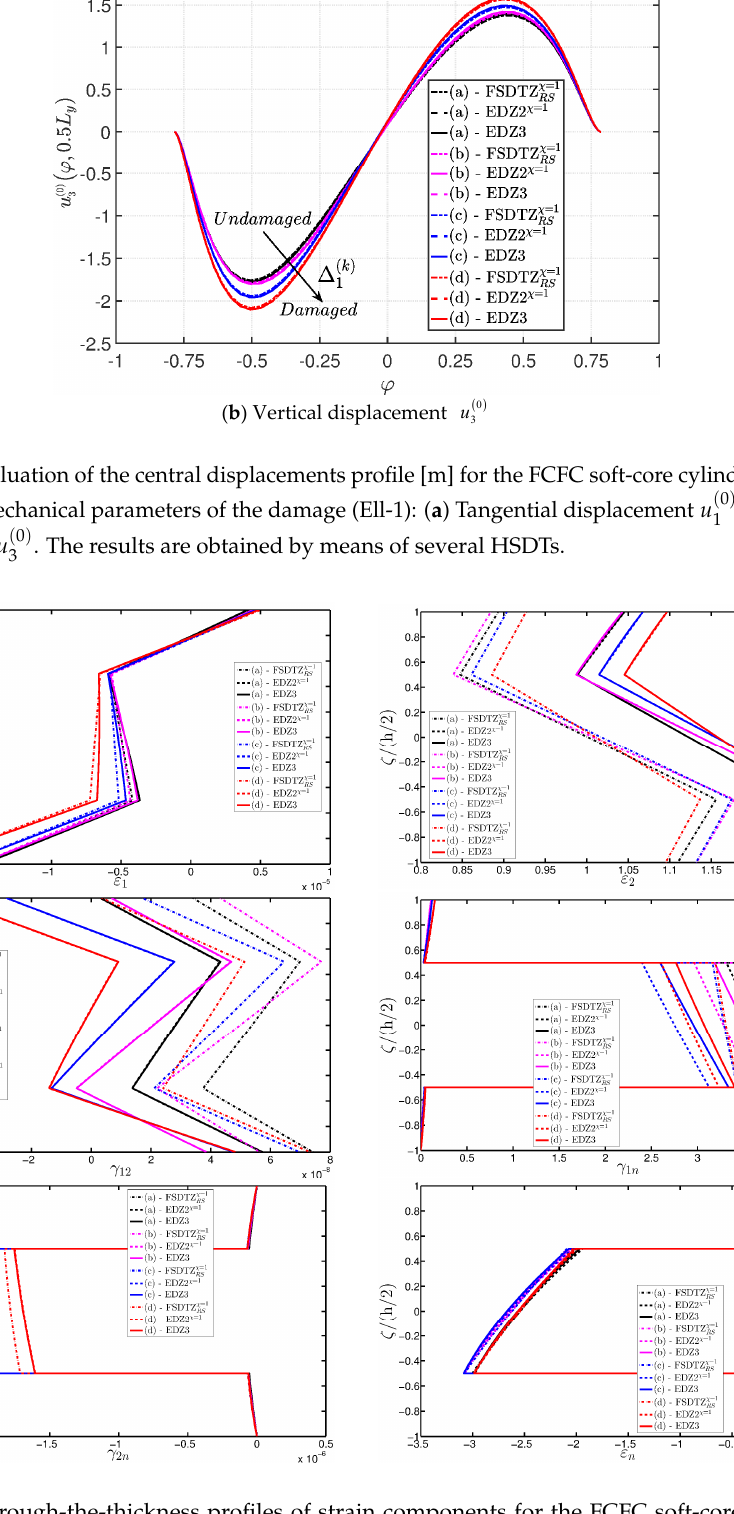
Figure 21. Through-the-thickness profiles of strain components for the FCFC soft-core cylindrical surface computed at the point B for different HSDTs. The effect of the damage is investigated by varying the parameters of the function Ell-1.